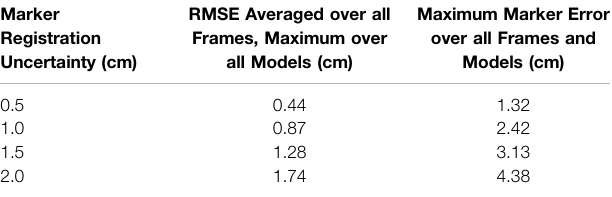
Frontiers in Bioengineering and Biotechnology |